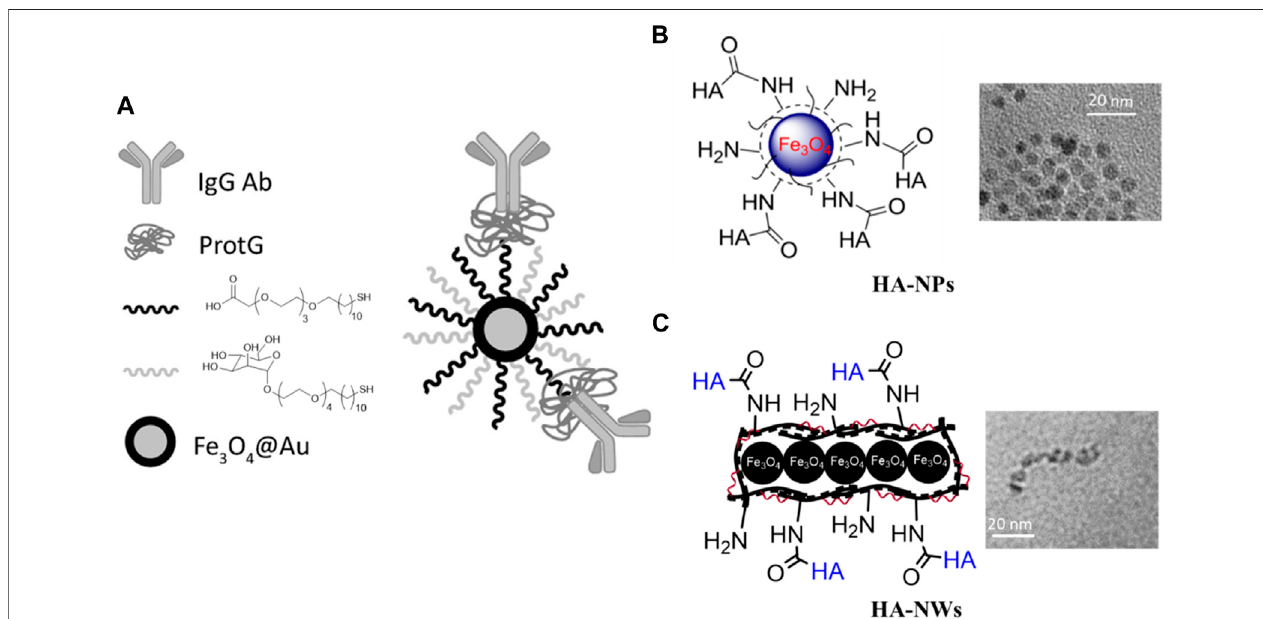
FIGURE 2 | Iron oxide nanoparticles for active targeting of atherosclerotic plaques. (A) Antibody directed nanoparticle for atherosclerotic plaque imaging. Gold coated iron oxide nanoparticles were fi rst functionalized with mannose and carboxylic acid ending ligand, then protG was immobilized on nanoparticles. Finally, the nanoparticlesweredecoratedwithananti-CD163antibody.ThesenanoparticleswereusedforMRIandCTimagingofplaques(Tarinetal.,2015)(Copyrightpermission fromElsevier). (B) HAconjugatedironoxideNPs.TheseMRIprobesweretargetedtowardstheCD44receptorforimagingofatheroscleroticplaques(El-Dakdouki et al., 2014). (C) HA conjugated worm shaped iron oxide nanoprobes. These HA-NWs induced lower in fl ammatory responsescompared to the corresponding HA-NPs with a spherical morphology (Hossaini Nasr et al., 2018) (Copyright permission from American Chemical Society).